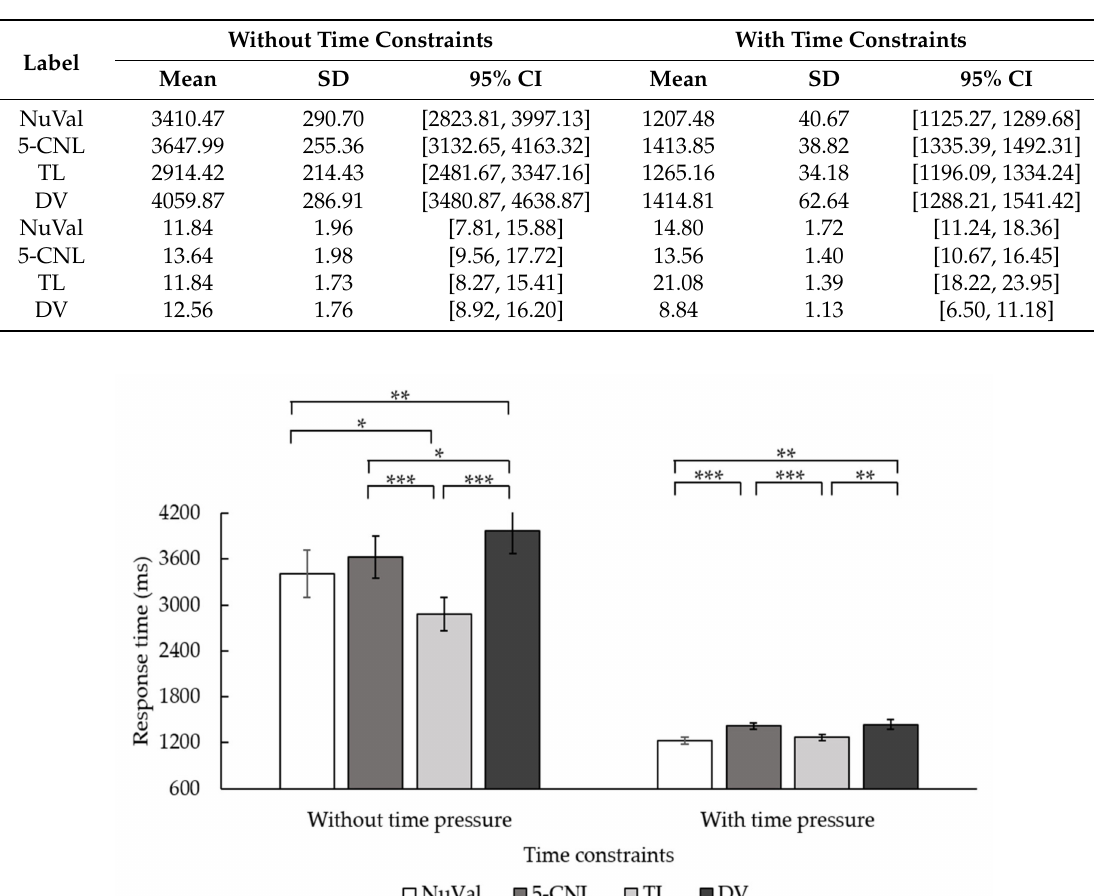
Table 2. Mean response time and the number of times choosing a type of nutrition label in Experi- ment 2.